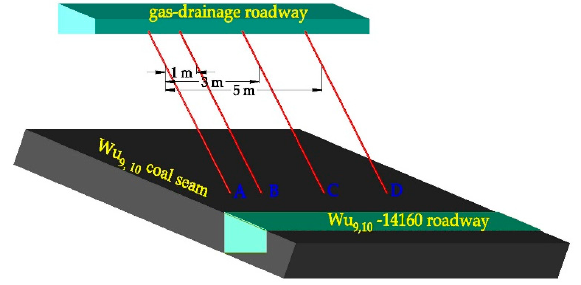
Figure 3. Borehole layout for influence-range determination.